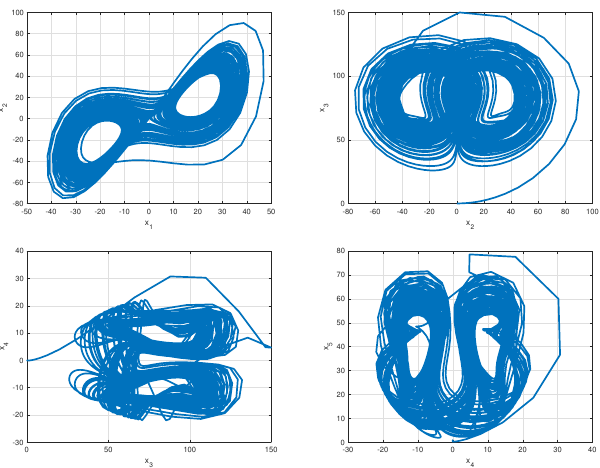
, r = 85, d = 19 , and α = 3 3